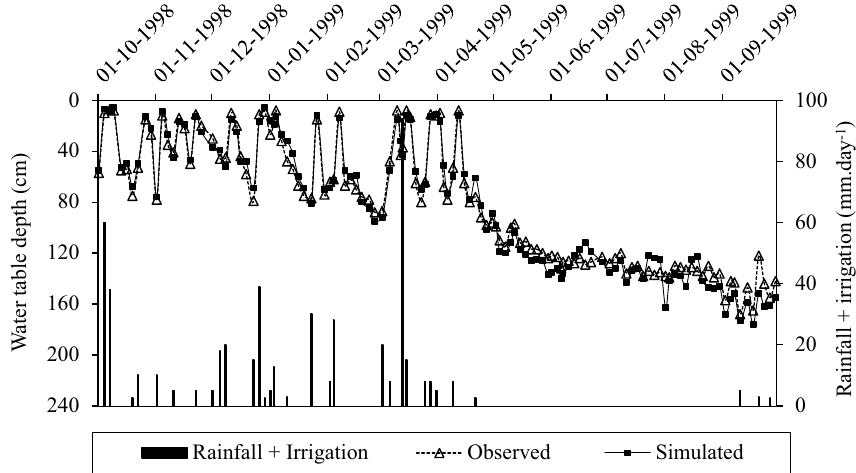
Fig. 4 Water table fluctuation during calibration